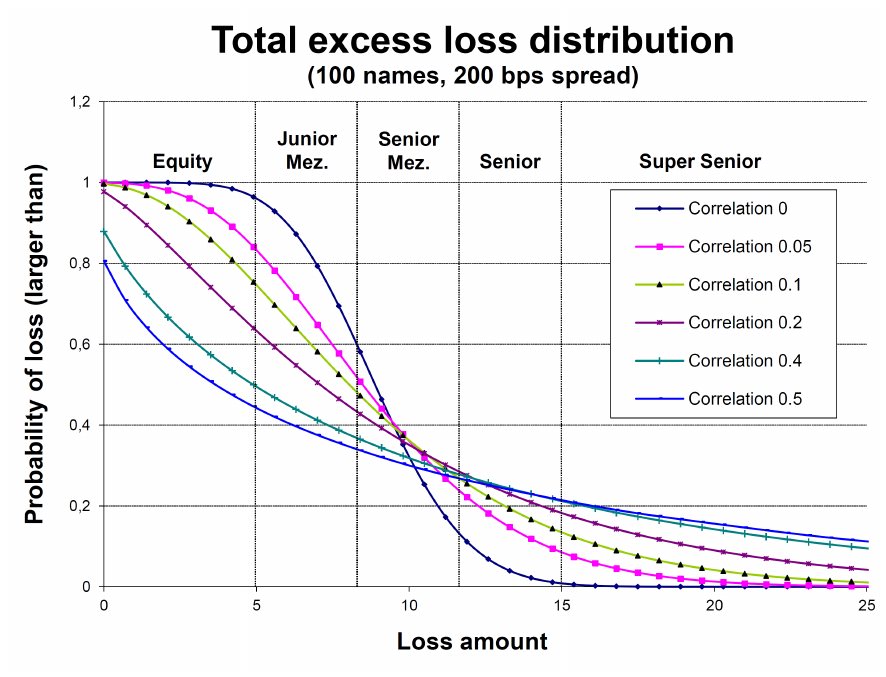
Figure 4: This graph shows the probability that the total portfolio loss is larger than a given amount, which we call excess loss distribution . It also shows the impact of asset correlation on the shape of the excess loss distribution. The expected loss of a CDO tranche is simply the area of the excess loss distribution line, bounded by the attachment and detachment